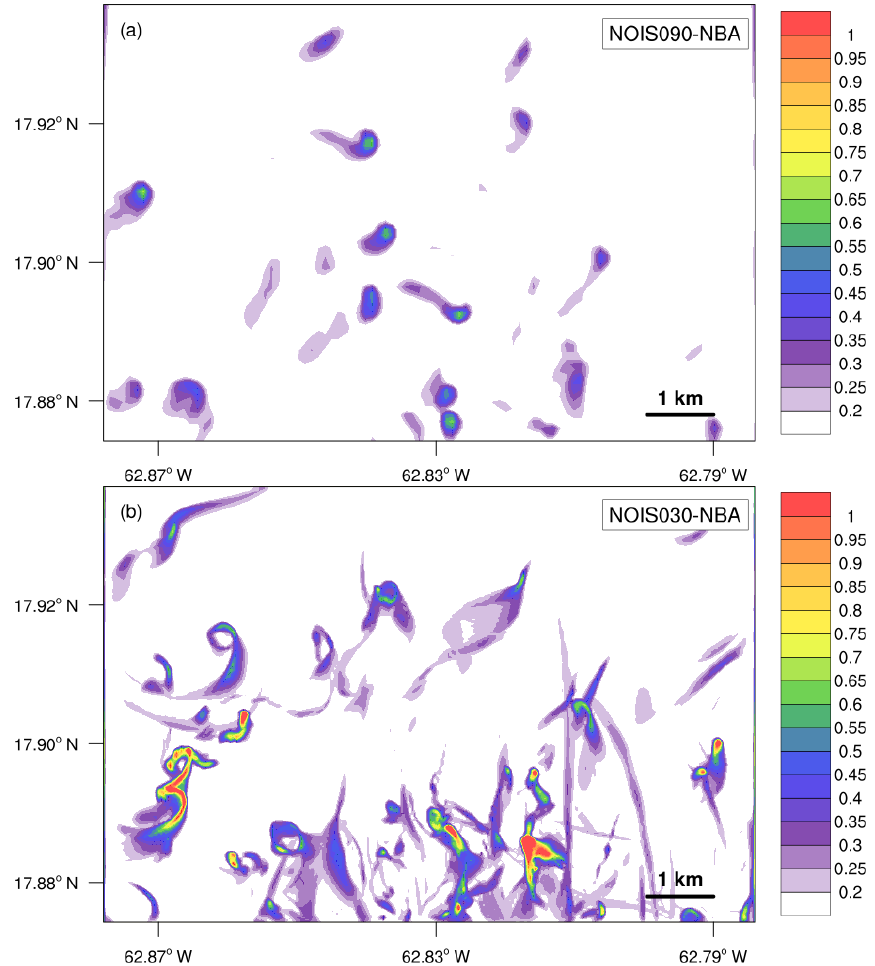
Figure 7. Maximum vertical vorticity (s − 1 ) over the 6h of simulation (history output interval of 1min) and the vertical column below 600m level: 90m resolution (a) and 30m resolution (b)